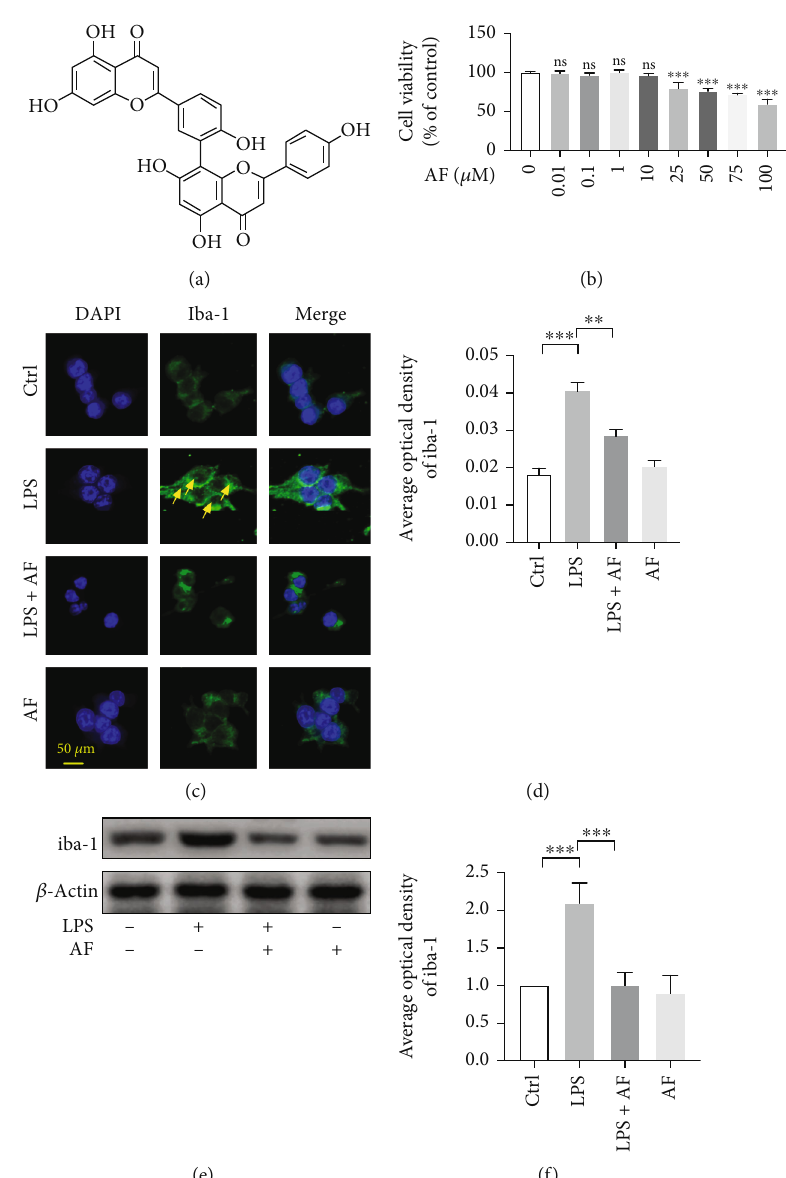
Figure 1: E ff ects of amento fl avone on LPS-induced activation of microglia in BV2 microglial cells. (a) Structure of amento fl avone. (b) Viability of BV2 microglial cells treated with amento fl avone in graded concentrations (0, 0.01, 0.1, 1, 10, 25, 50, 75, and 100 μ M) was measured by MTT assay (one-way ANOVA followed by Dunnett ’ s test). (c) Representative images of immuno fl uorescence staining of iba-1 in BV2 microglial cells. (d) Semiquantitative analysis of the relative levels of iba-1 by densitometric analysis. (e) Representative immunoblots of iba-1 protein in BV2 microglial cells. (f) Semiquantitative analysis of the relative level of iba-1 by densitometric analysis. Error bars represent mean ± s : d . ∗∗ and ∗∗∗ represent P < 0 : 01 and P < 0 : 001 , respectively. All experiments were performed in triplicate. LPS: lipopolysaccharide; AF: amento fl